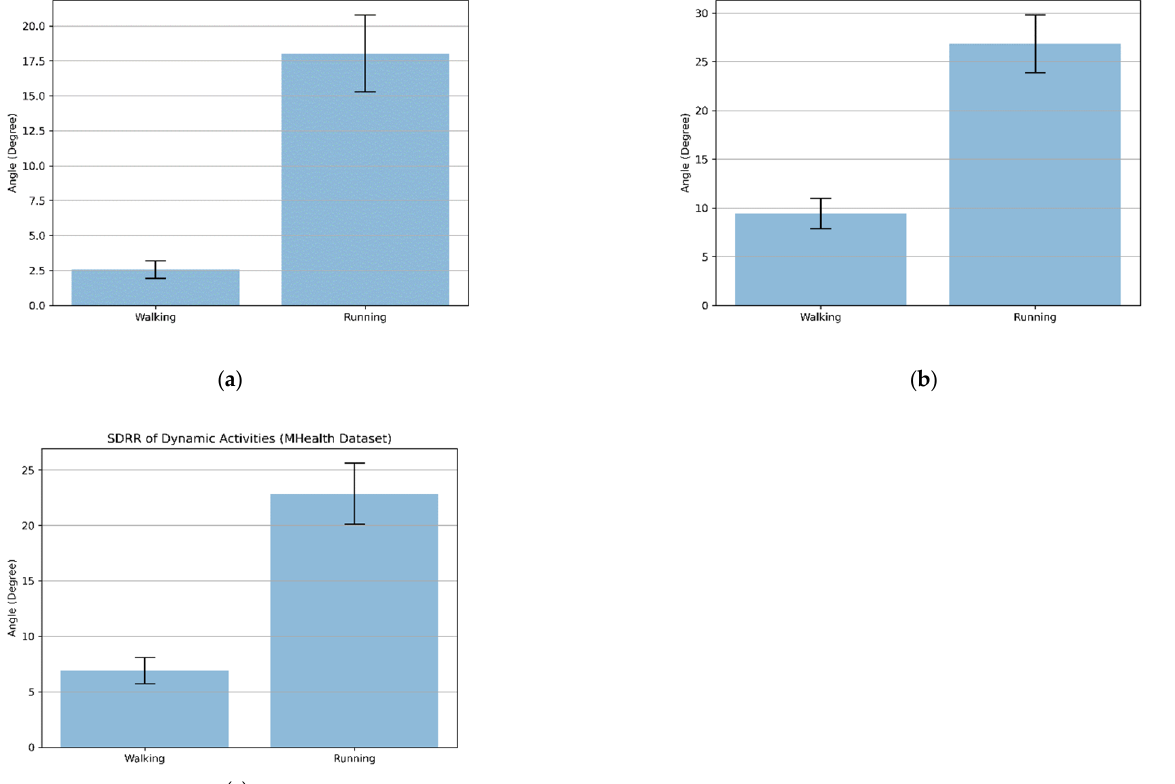
Table 1. Accuracy with count-based and angle-based classification for the HAR dataset.